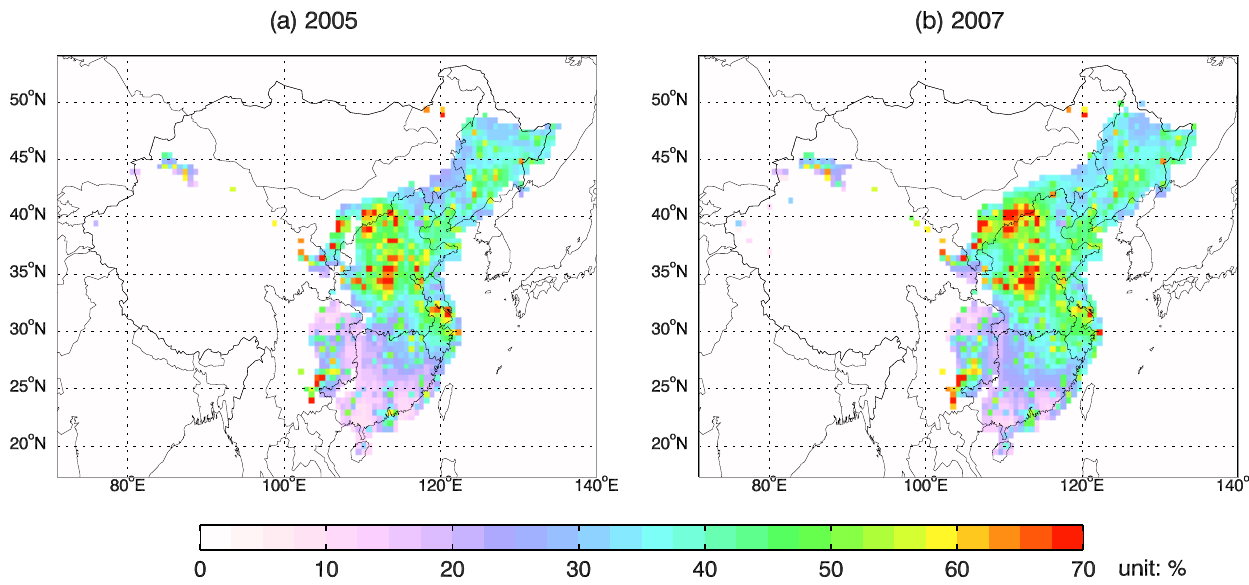
Fig. 11. Relative contributions of the power plant NO x emissions to the annual average NO 2 columns in (a) 2005 and (b) 2007, de- fined as the relative differences between GC PP and GC NoPP. Only grids inside Chinese boundary and with average NO 2 columns > 1.0 × 10 15 moleculescm − 2 in GC PP are